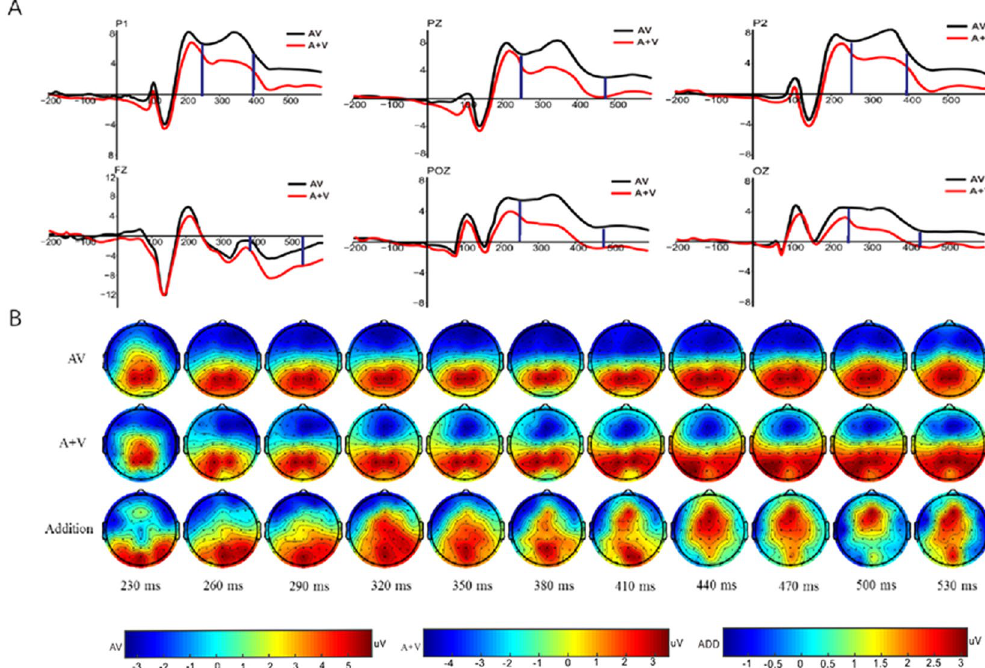
Figure 3. ( A ) Grand average ERP waveforms under the AV and A + V conditions at the six primary electrodes (P1, PZ, P2, FZ, POZ, and OZ); substantial differences were observed between the AV and A + V conditions for these electrodes over a latent period of 236–530 ms (between the two vertical blue lines). ( B ) Scalp topography distributions for the steps of instantaneous amplitude values during the AV, A + V, and addition[ADD, AV − (A + V)]